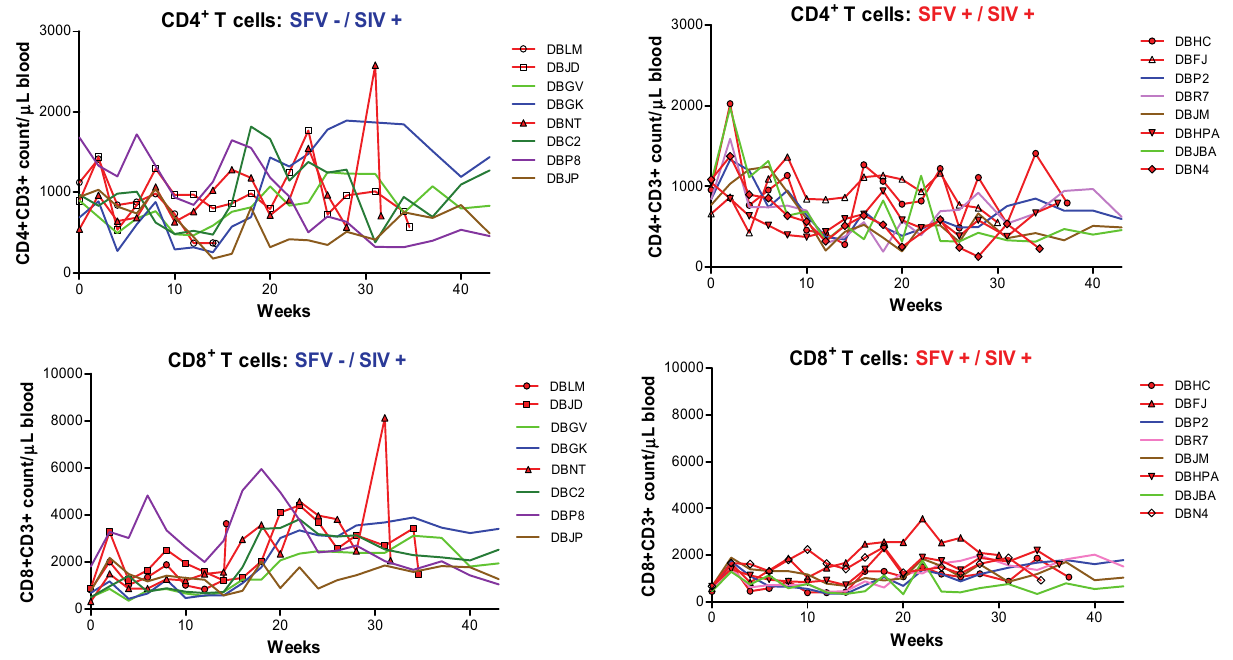
Figure 2. Comparison of CD4 + and CD8 + T cells in SIV-infected monkeys. The numbers of CD4 + T cells and CD8 + T cells were determined for week 0 (prior to SIV injection) and after injection through week 43 for each monkey or earlier in case of termination due to disease (indicated in red with a symbol). Animals are grouped based upon SFV status for comparison and listed individually in each